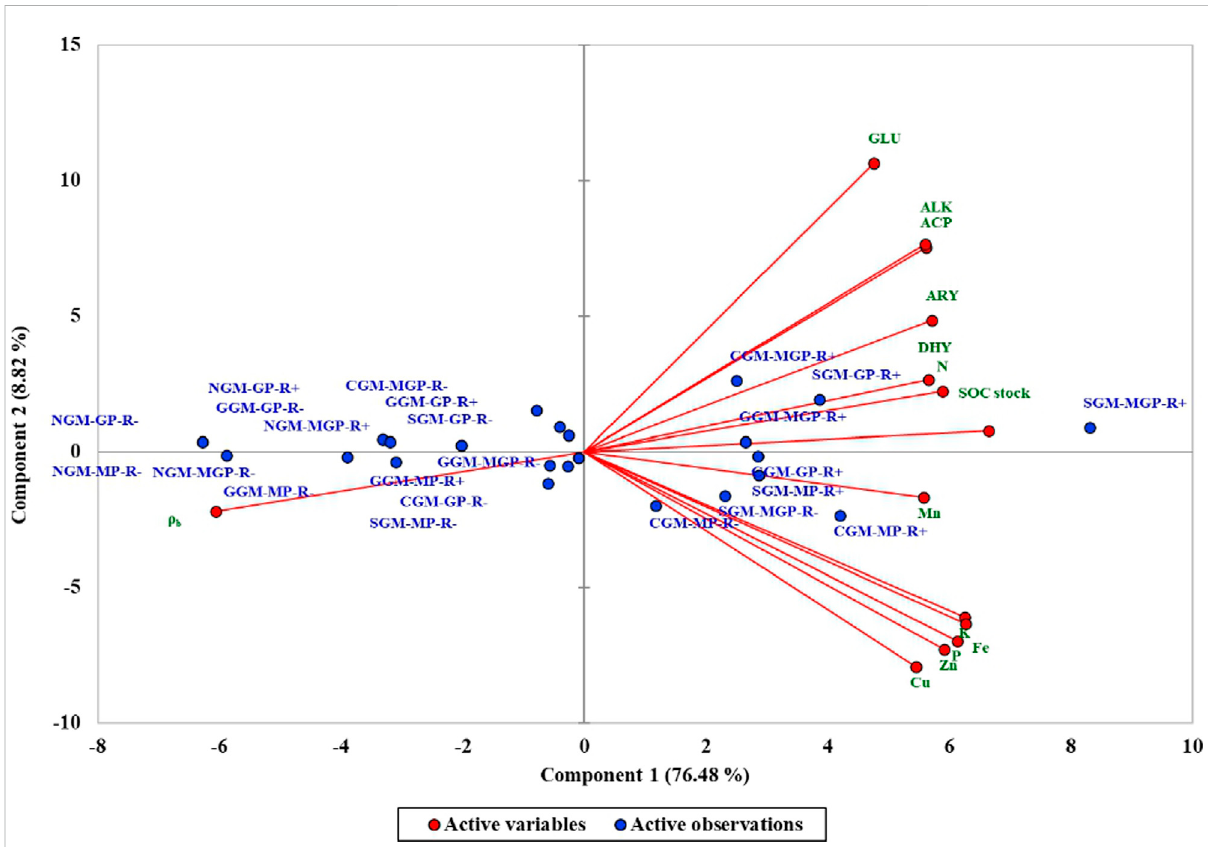
FIGURE 4 Principal component analysis (PCA). of system productivity and soil variables for treatment combinations of green manuring, cropping system, and residue management practices. NGM: No green manuring, GGM: greengram green manuring, CGM: cowpea green manuring, SGM: sesbania green manuring, GP: groundnut – pea, MP: maize – pea, MGP: maize + groundnut – pea, R-: residue removal, R+: Available phosphorus, K: Available potassium, Fe, Mn, Zn, Cu: DTPA-extractable soil micronutrients iron, manganese, zinc, and copper, respectively. ACP: Acid phosphates (u